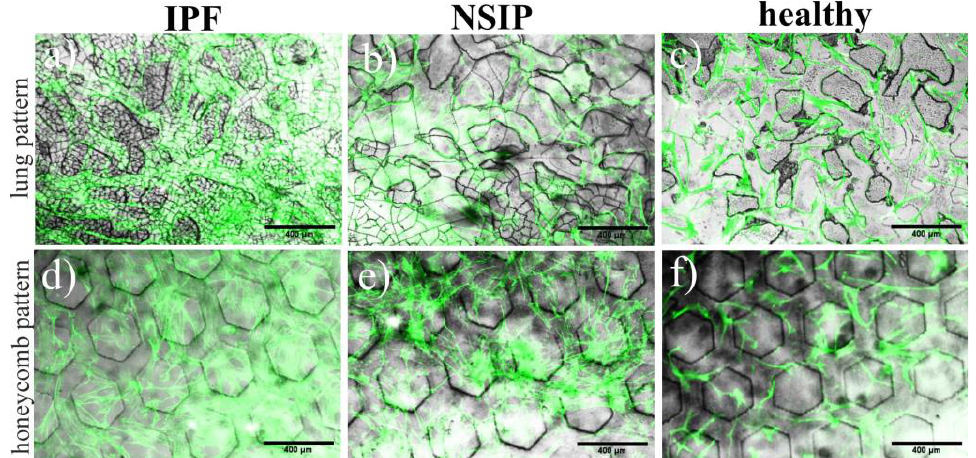
Figure 8. Fluorescent images of ( a , d ) IPF-, ( b , e ) NSIP-derived, and ( c , f ) healthy fibroblasts cultured on 3D PDMS structures mimicking ( a – c ) natural and ( d – f ) honeycomb lung architecture prepared by molding and recorded using optical microscopy. The scale bar corresponds to 200 μ m (objective magnification 10×).